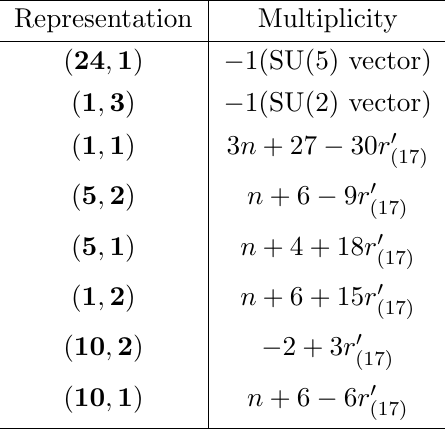
Table 6 . The spectrum for the con(cid:12)guration No.17. Another